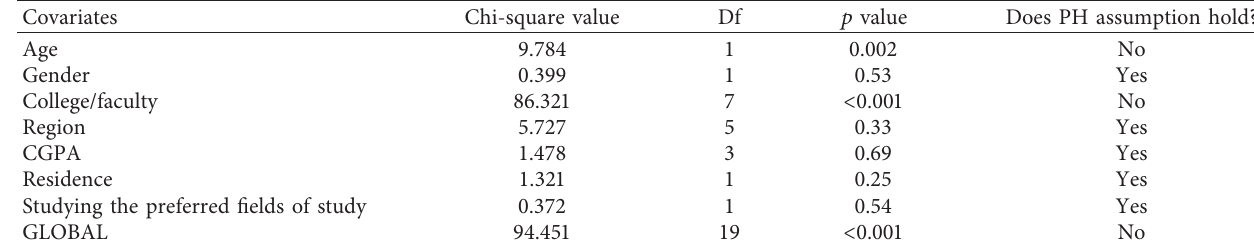
Table 3: Proportional hazard assumption checking for the covariates.